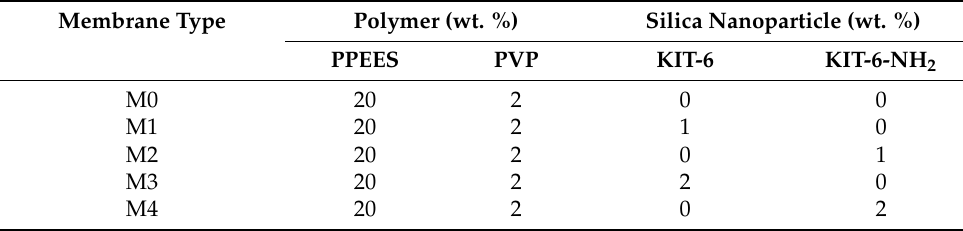
Table 1. Compositions of the casting